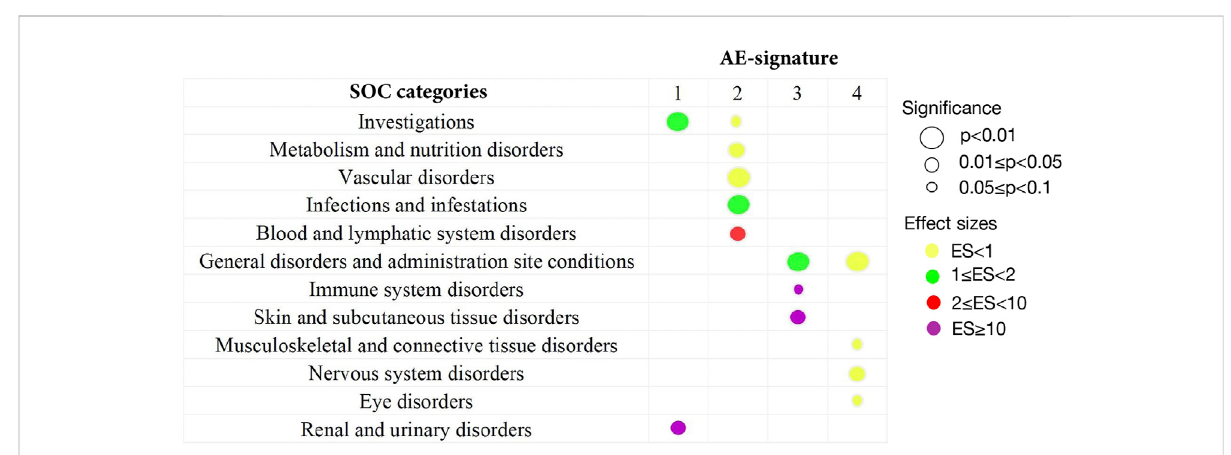
FIGURE 2 Summary of statistically signi fi cant SOC categories returned by the one-sided Wilcoxon rank test. All 134 AEs extracted from the CEUAFD are classi fi edintodifferentSOCcategoriesinMedDRA.Bytheone-sidedWilcoxonranktest,onlysigni fi cantassociationsbetweentheSOCcategoryand AE signature are shown. The size of the circles corresponds to different levels of p values. The colors represent different effect sizes (ESs) of the association between the SOC category and AE